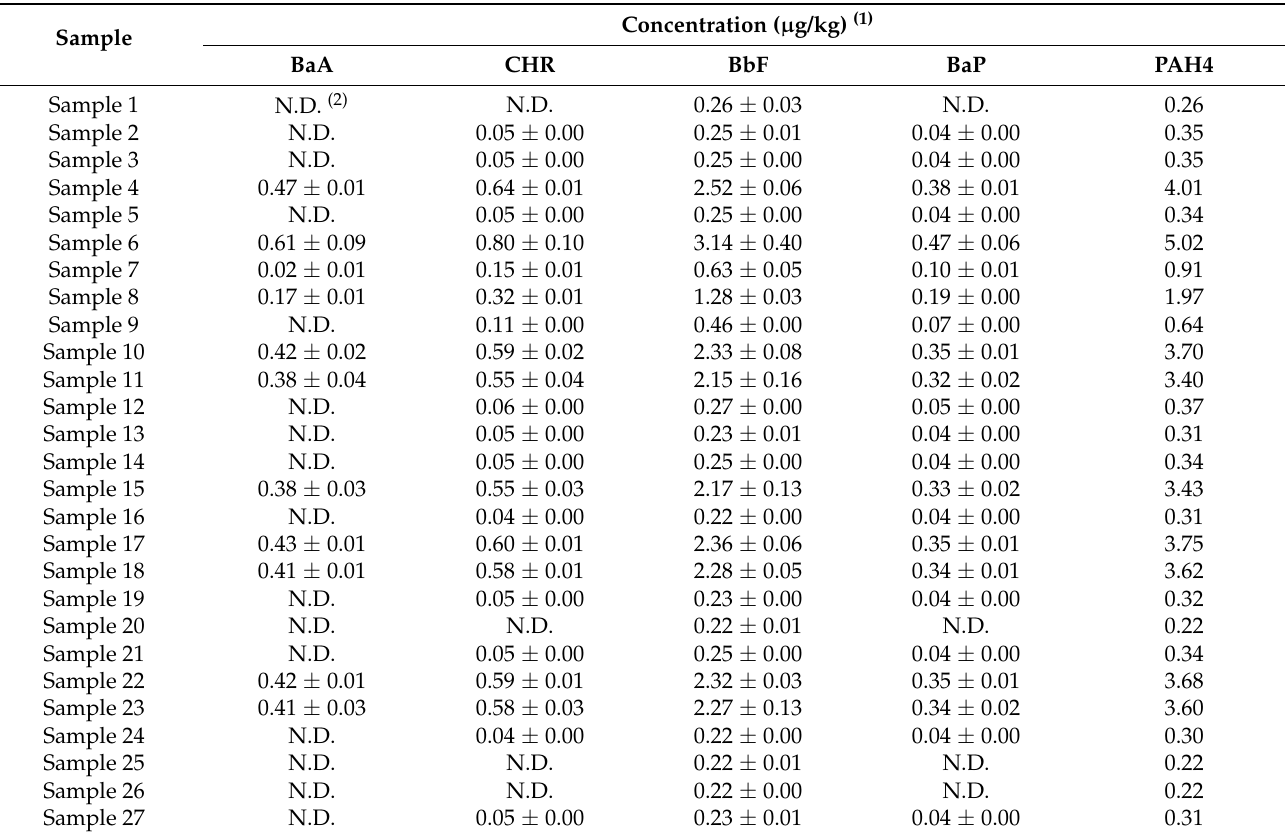
Table 4. PAH4 concentration in herbal medicines analyzed using QuEChERS pretreatment